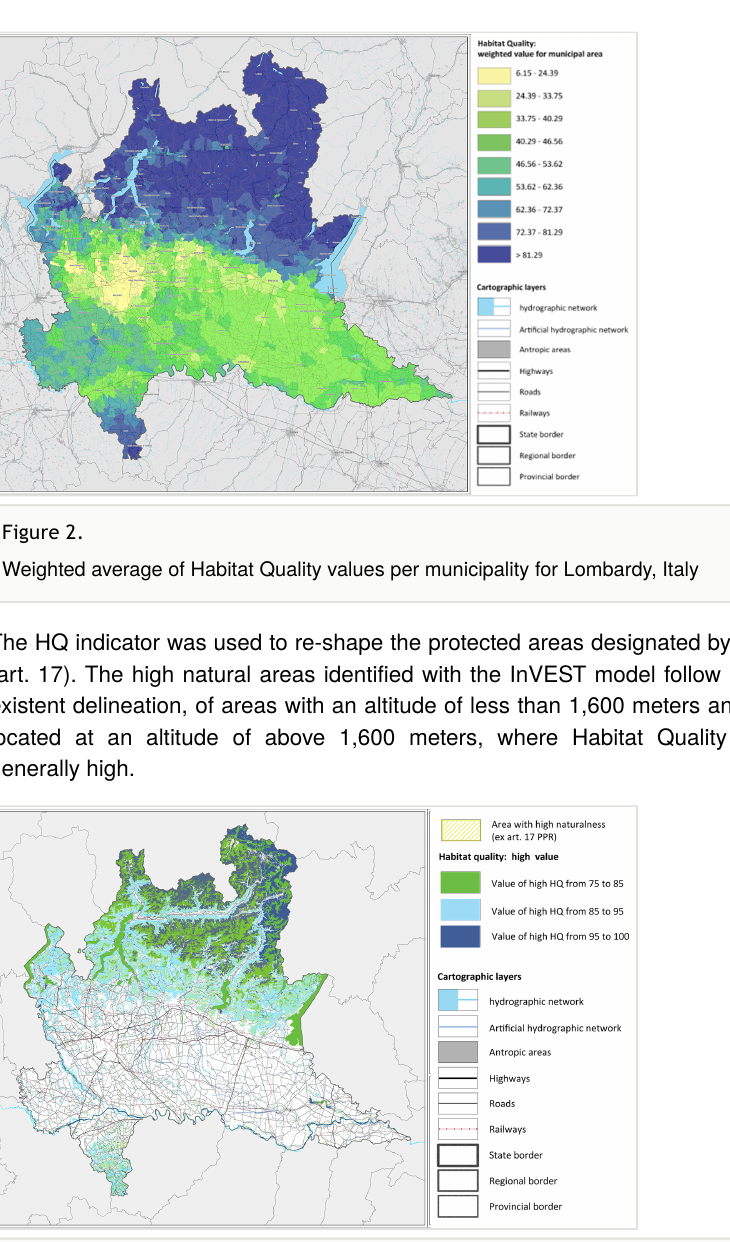
Overlay between area with high natural value designated under art. 17 of the Landscape Regional Plan and area with a high value of Habitat Quality based on the habitat quality indicator derived from the InVEST